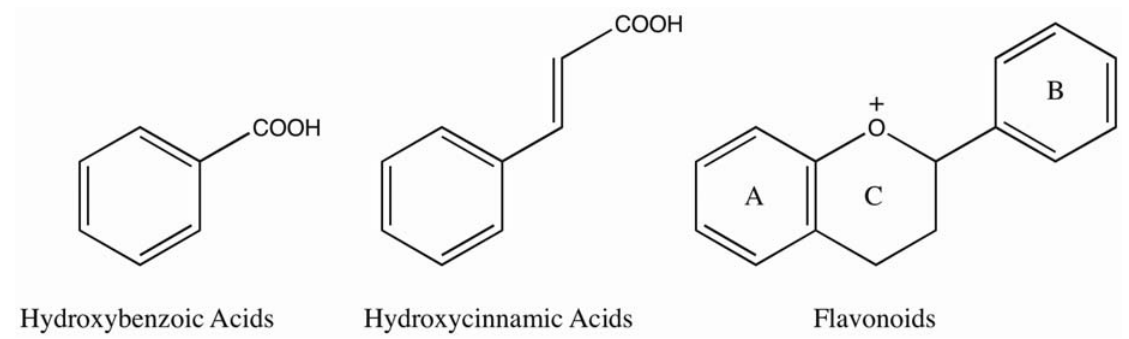
Figure 1. Basic structures of phenolic acids and